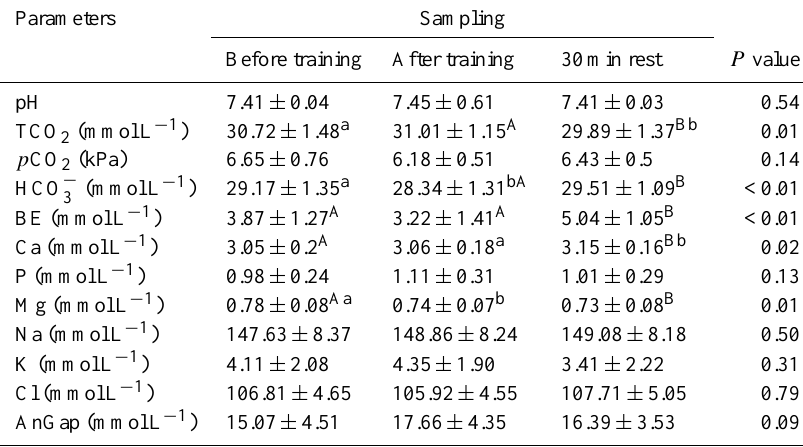
Table 2. Parameters of acid–base balance and concentration of selected macroelements and electrolytes before and after horses’ training (mean ± standard deviation).